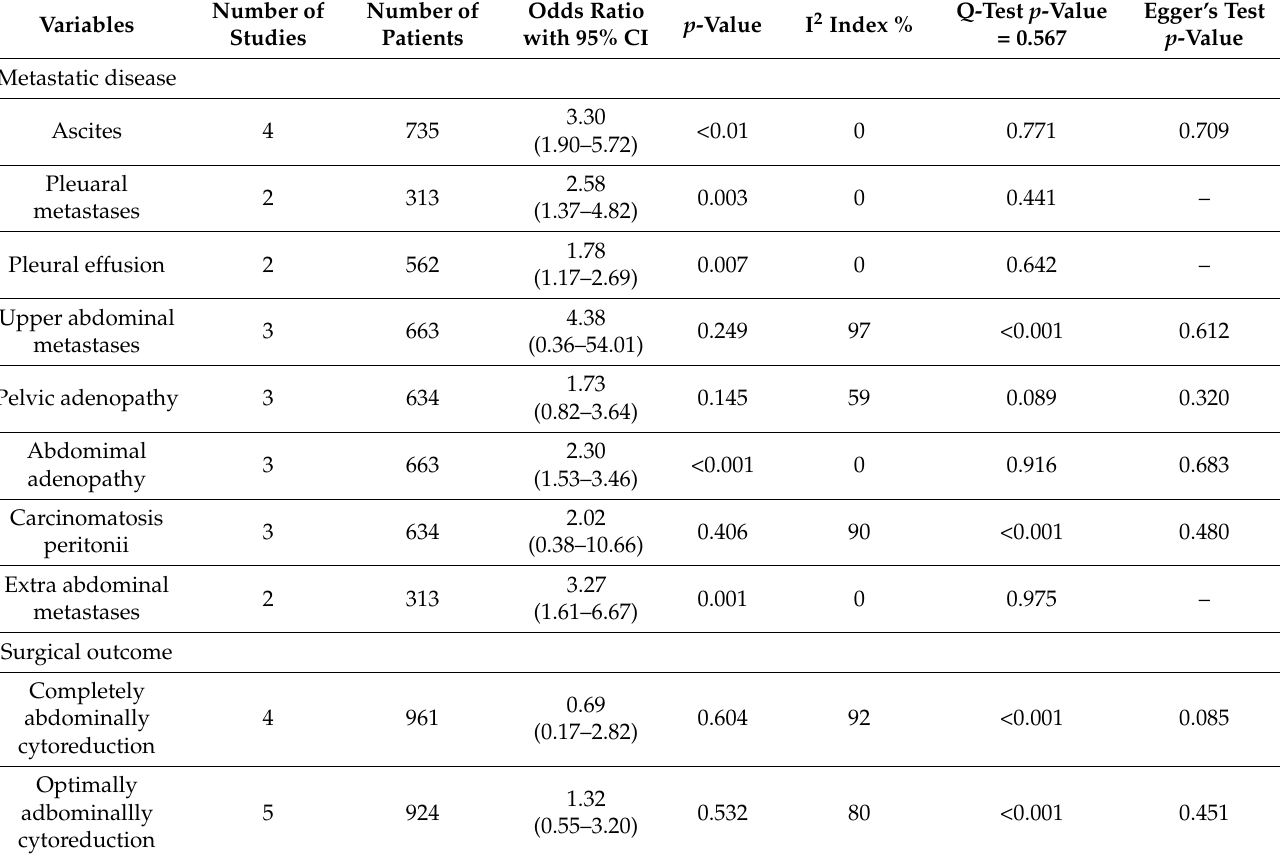
Table 3. Meta-analysis of clinical characteristics of patients with CPLN adenopathy, compared with patients without CPLN